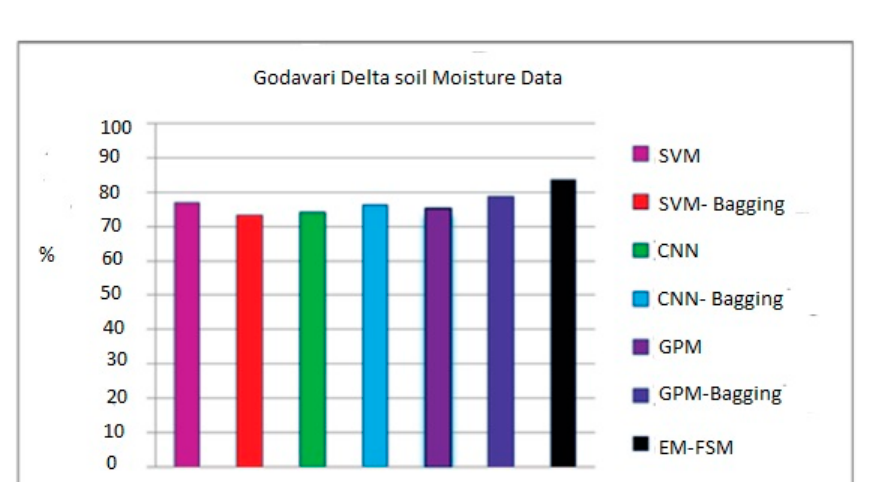
Figure 15. Prediction accuracy of di ff erent classi fi ers.